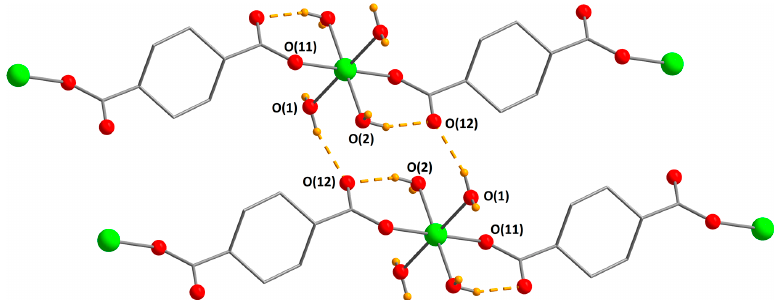
Figure 1. Packing of polymeric chains in 1 (CCDC 1973662). Metal atoms are green, O atoms are red, H atoms of aqua-ligands are orange. Hydrogen bonds are shown with dashed lines. H atoms of chdc 2 − ligands are omitted.